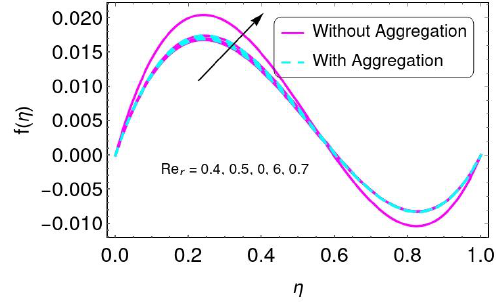
Figure 9. The results of Re r on f ( η ) .